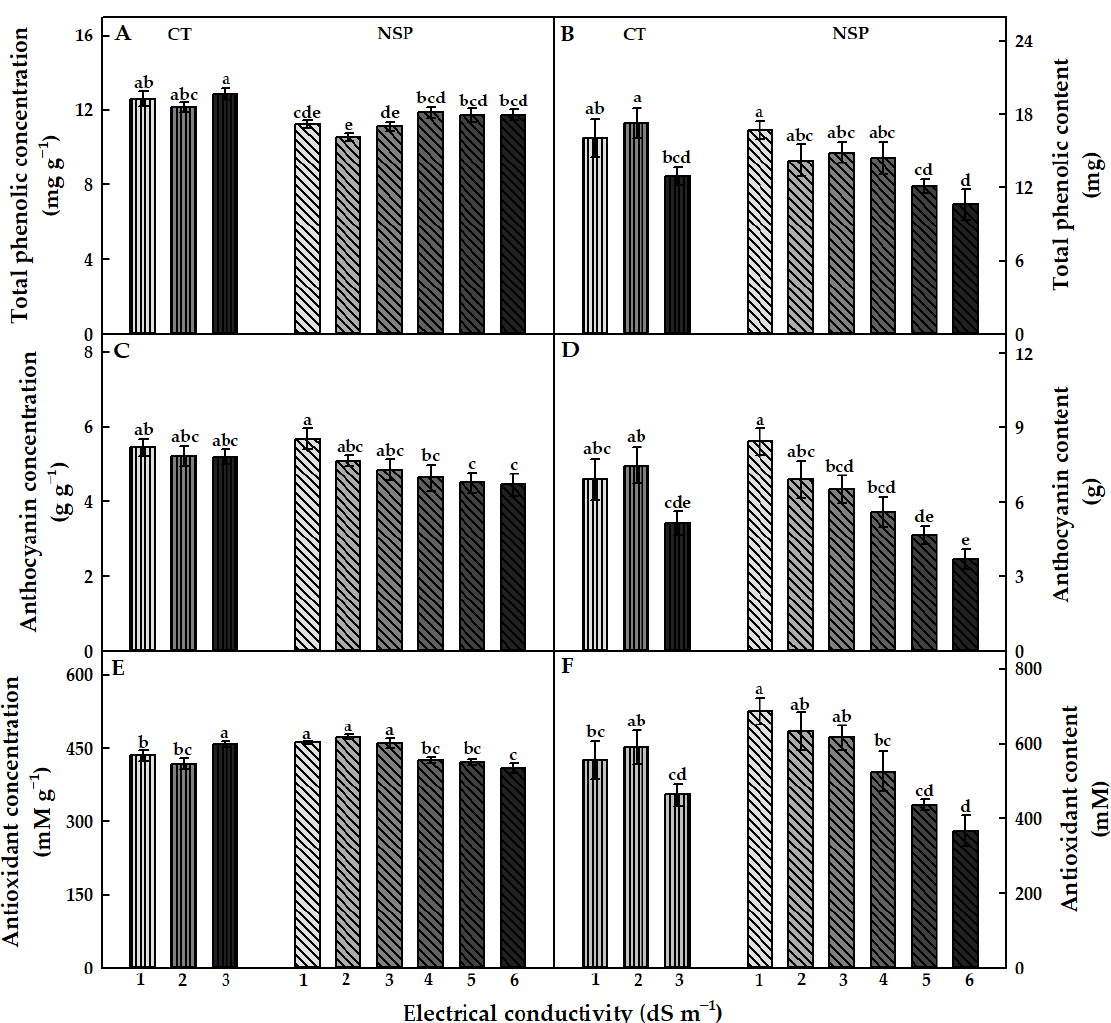
Figure 5. Total phenolic, total anthocyanin, and antioxidant concentration ( A , C , E ) and content ( B , D , F ) of red perilla plants grown under various EC levels of greenhouse nutrient solution (CT) and the newly-developed nutrient solution for red perilla (NSP) after 7 weeks of transplanting. Different letters indicate significant difference at p < 0.05 ( n = 9).